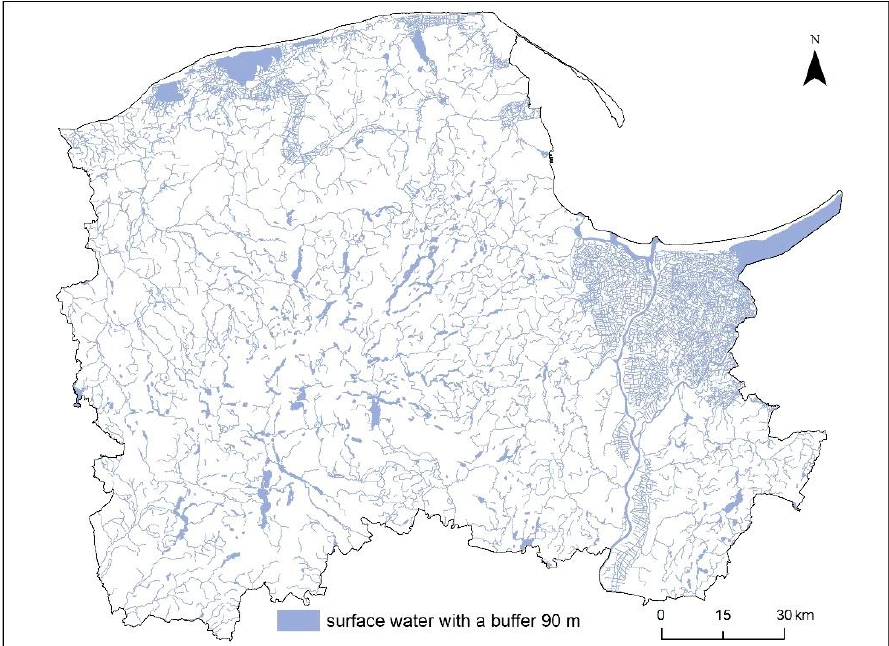
Figure 5. Water surfaces with 90 m buffer (own elaboration).